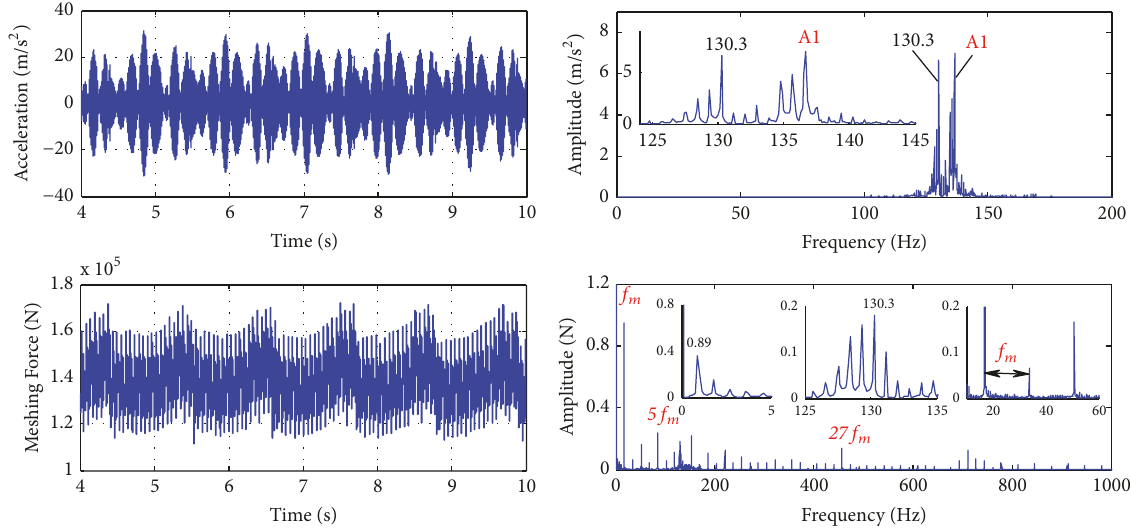
Figure5:Time-domainandfrequency-domaincurvesoftheaxialvibrationaccelerationonthecutterheadnodeandthedynamicpinion-ring gear meshing